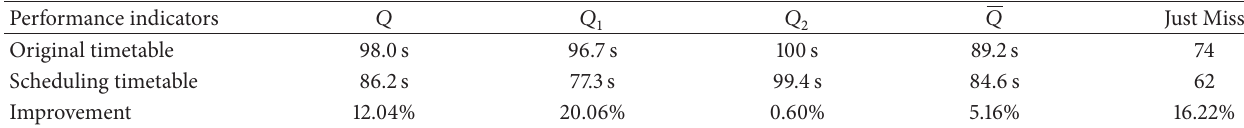
Table 4: Result comparison of the numerical